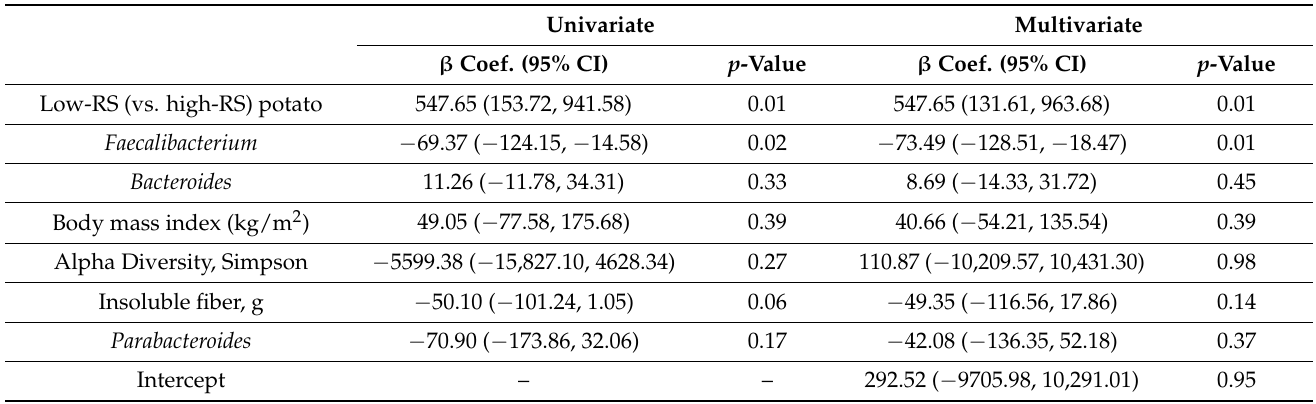
Table 4. Unadjusted and adjusted coefficients from linear regression that predict postprandial glucose